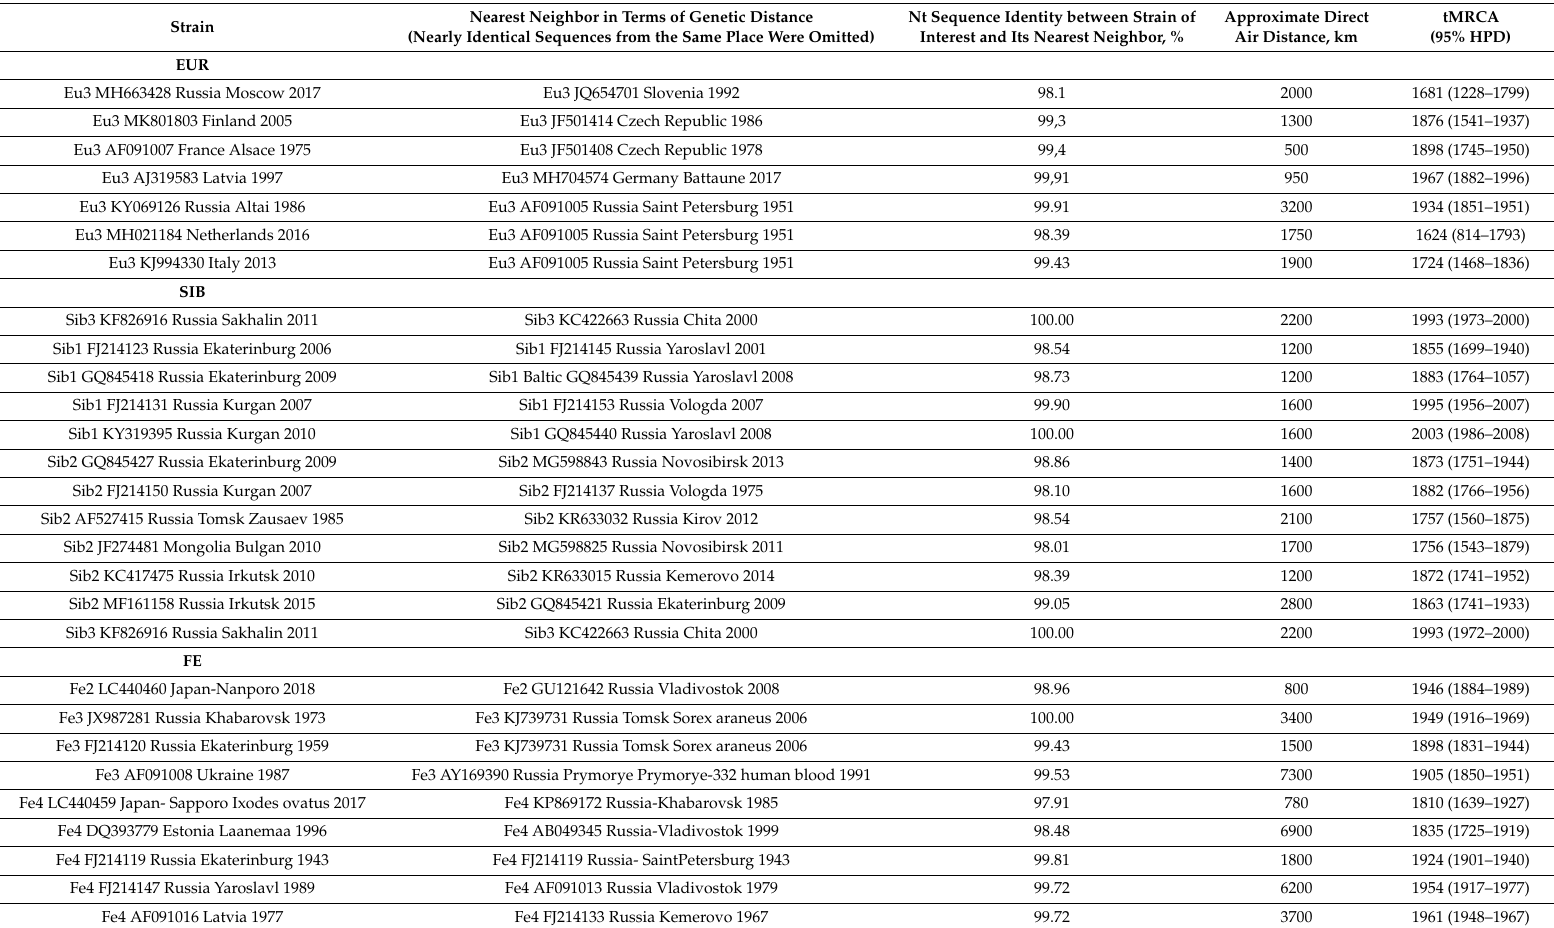
Table 1. Closely related viruses found at distant locations. Strain Nearest Neighbor in Terms of Genetic Distance (Nearly Identical Sequences from the Same Place Were